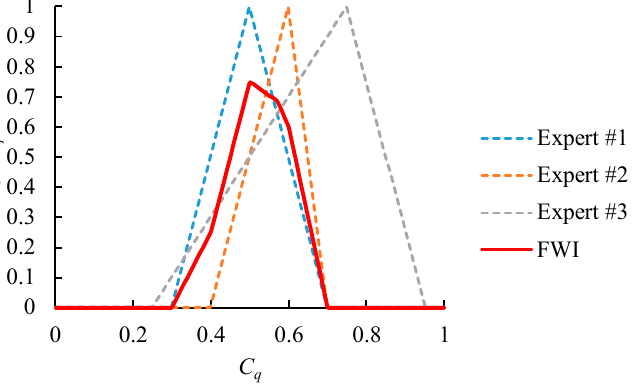
Figure 6. An example of the fuzzy weighted intersection (FWI) aggregator ({ ω k } = (0.6, 0.3,